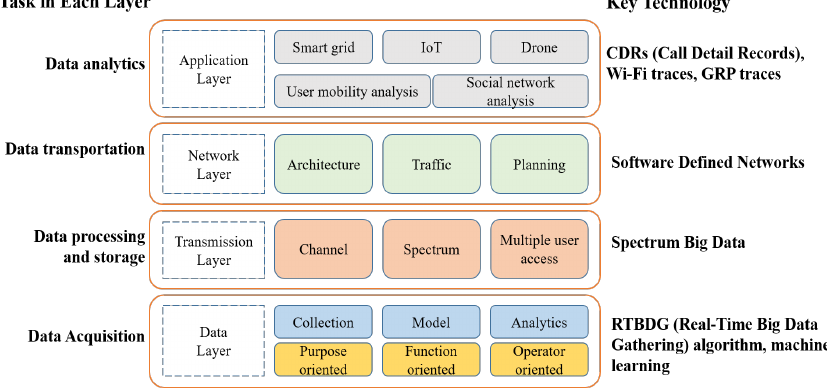
Figure 2. Protocol layering of wireless big data